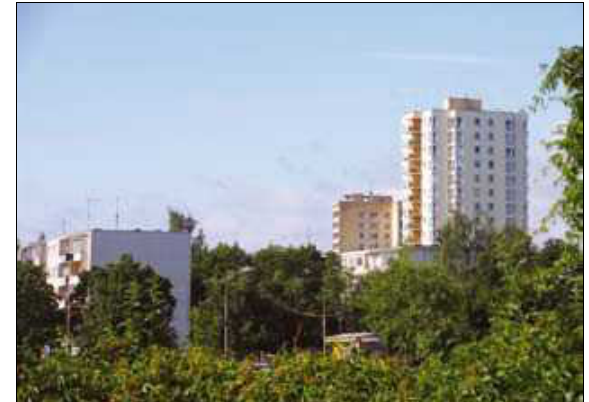
9 pav. Dau­giabu­tis gyvenamasis namas L. a­sanavičiūtės g. (archit. S. Dagelienė, S. Dagelis) Fig. 9. block of flats in L. a­sanavičiūtė st. a­rch. S. Dagelienė, S. Dagelis